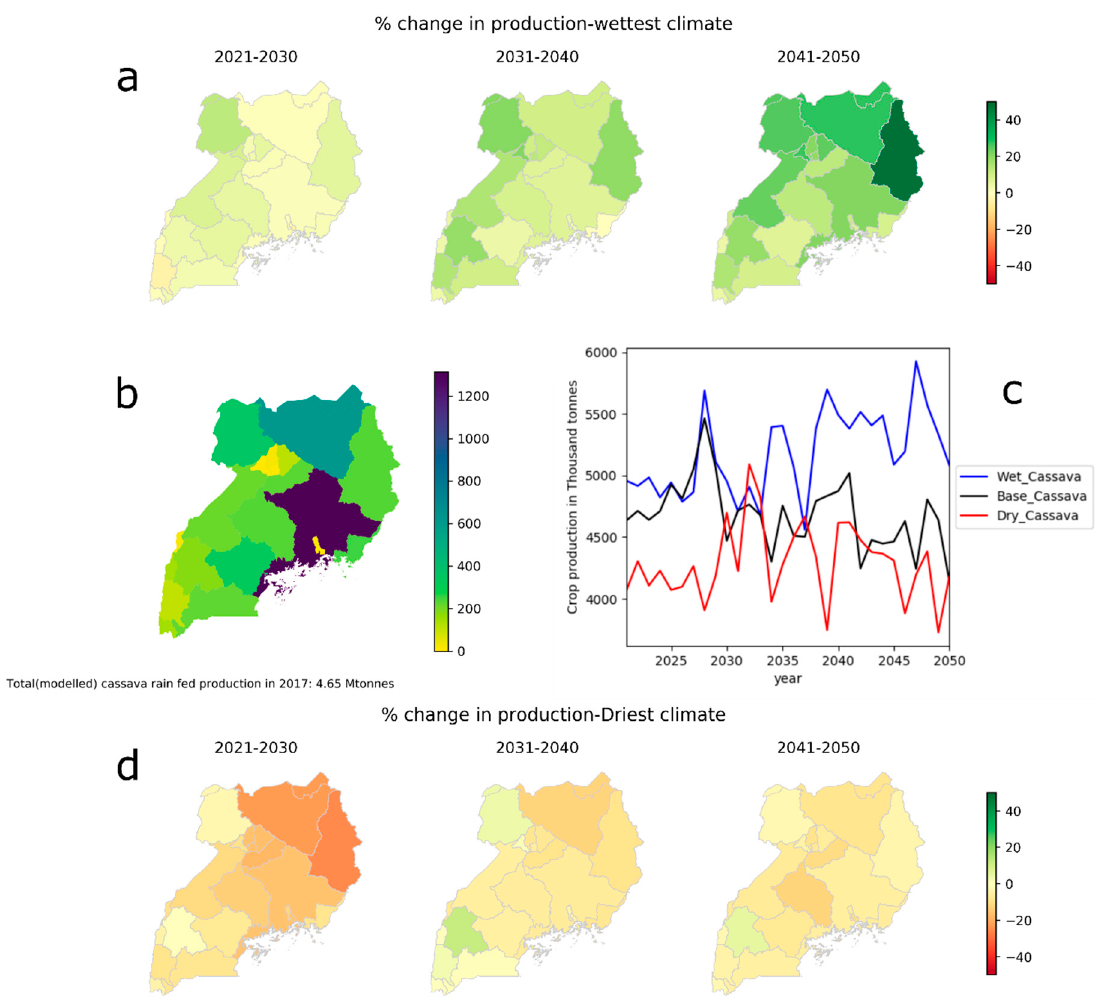
Figure 8. Climatic impact on cassava production. Catchment specific di ff erences in crop production in the ( a ) wettest and ( d ) driest climate futures and the reference scenario is presented. Total modelled (catchment specific) cassava production ( b ) in 2017 is provided to di ff erentiate high production zones from the rest. Parts ( a ) and ( d ) should always be interpreted in relation with part ( b ). The line graph ( c ) provides the annual variation in cassava production between the analyzed climate futures on a national level.